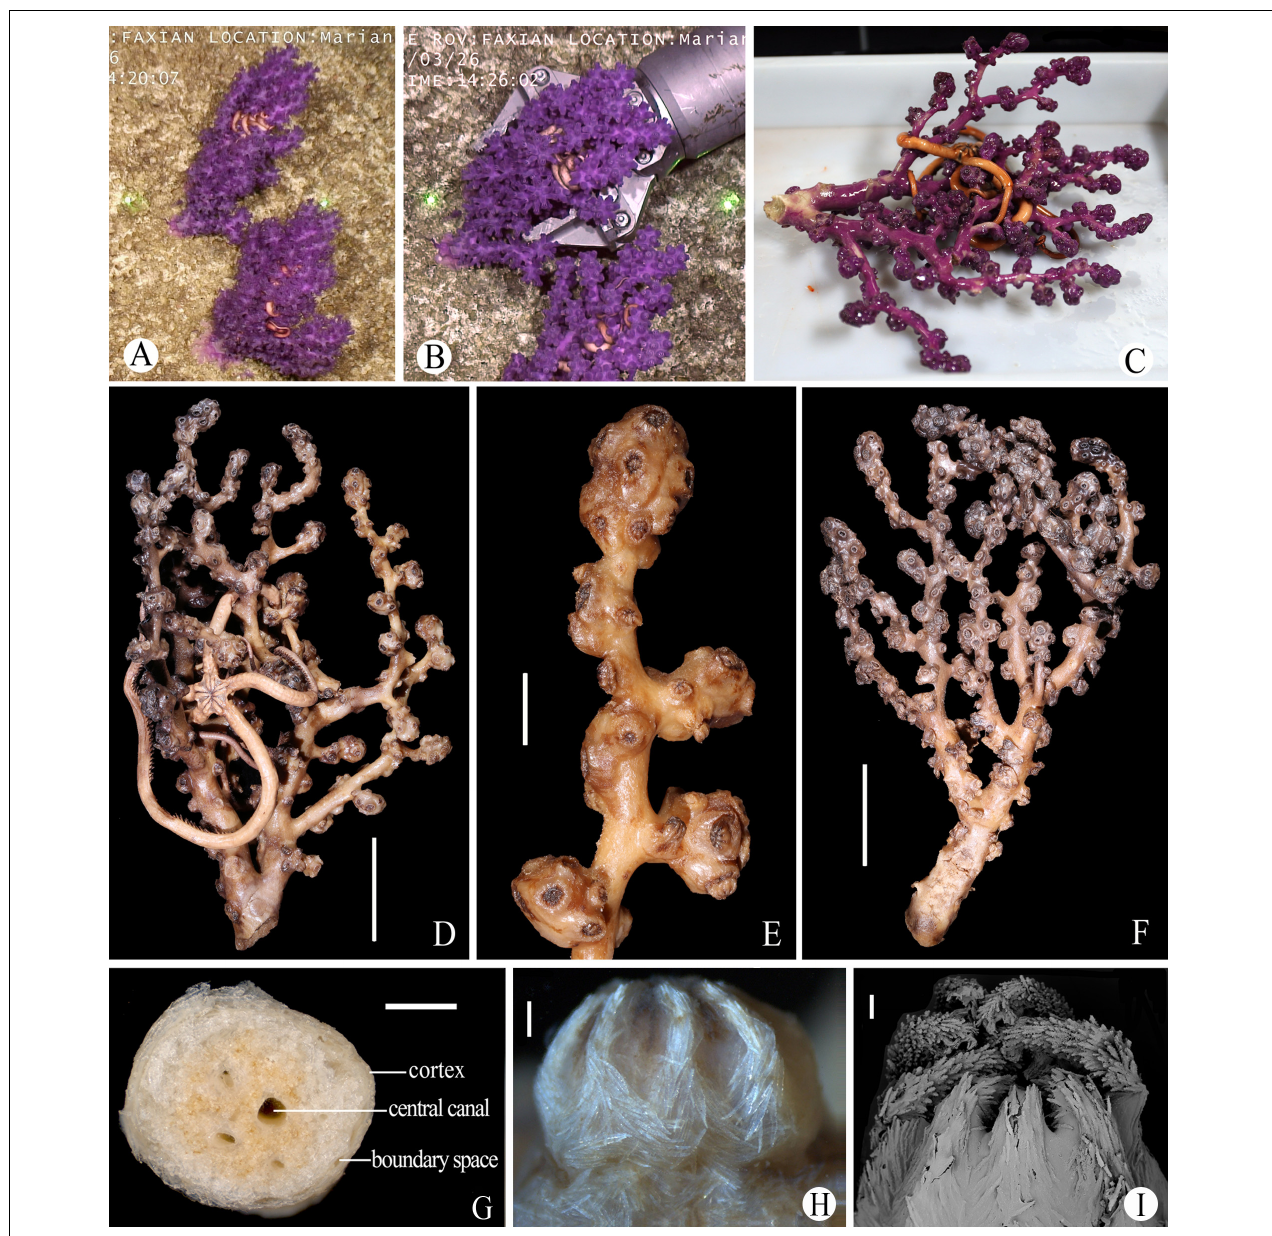
FIGURE 3 | Morphology of Victorgorgia fasciculata sp. nov. (A) In situ . (B) The specimens when collected, showing contracted polyps in situ . (C) The newly collected holotype, photographed by Xuwen Wu. (D) The holotype in preservation. (E) An enlarged branch of the holotype. (F) The paratype. (G) Cross-section of terminal medulla. (H) Lateral view of polyp head of the holotype. (I) SEM of polyp head of the holotype. Laser dots spaced at 33 cm used for measuring dimensions (A,B) . Scale bars = 5 cm (D,F) , 1 cm (E) , 1 mm (G) , 0.5 mm (H) , and 0.2 mm (I)